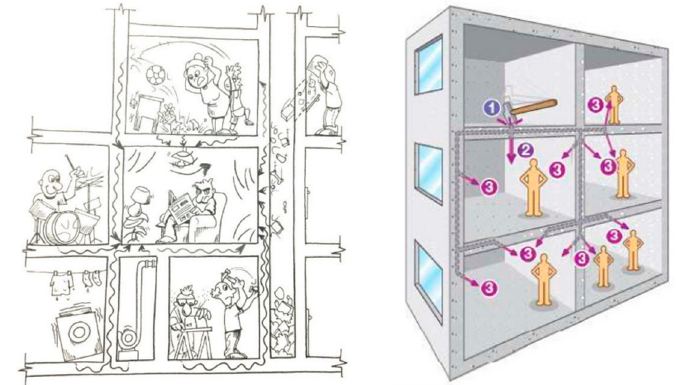
Figure 1. Illustrations of transmission of noise generated by impacts [18]. Legend: 1-Impact noise; 2-direct sound transmission and 3-indirect sound transmission.